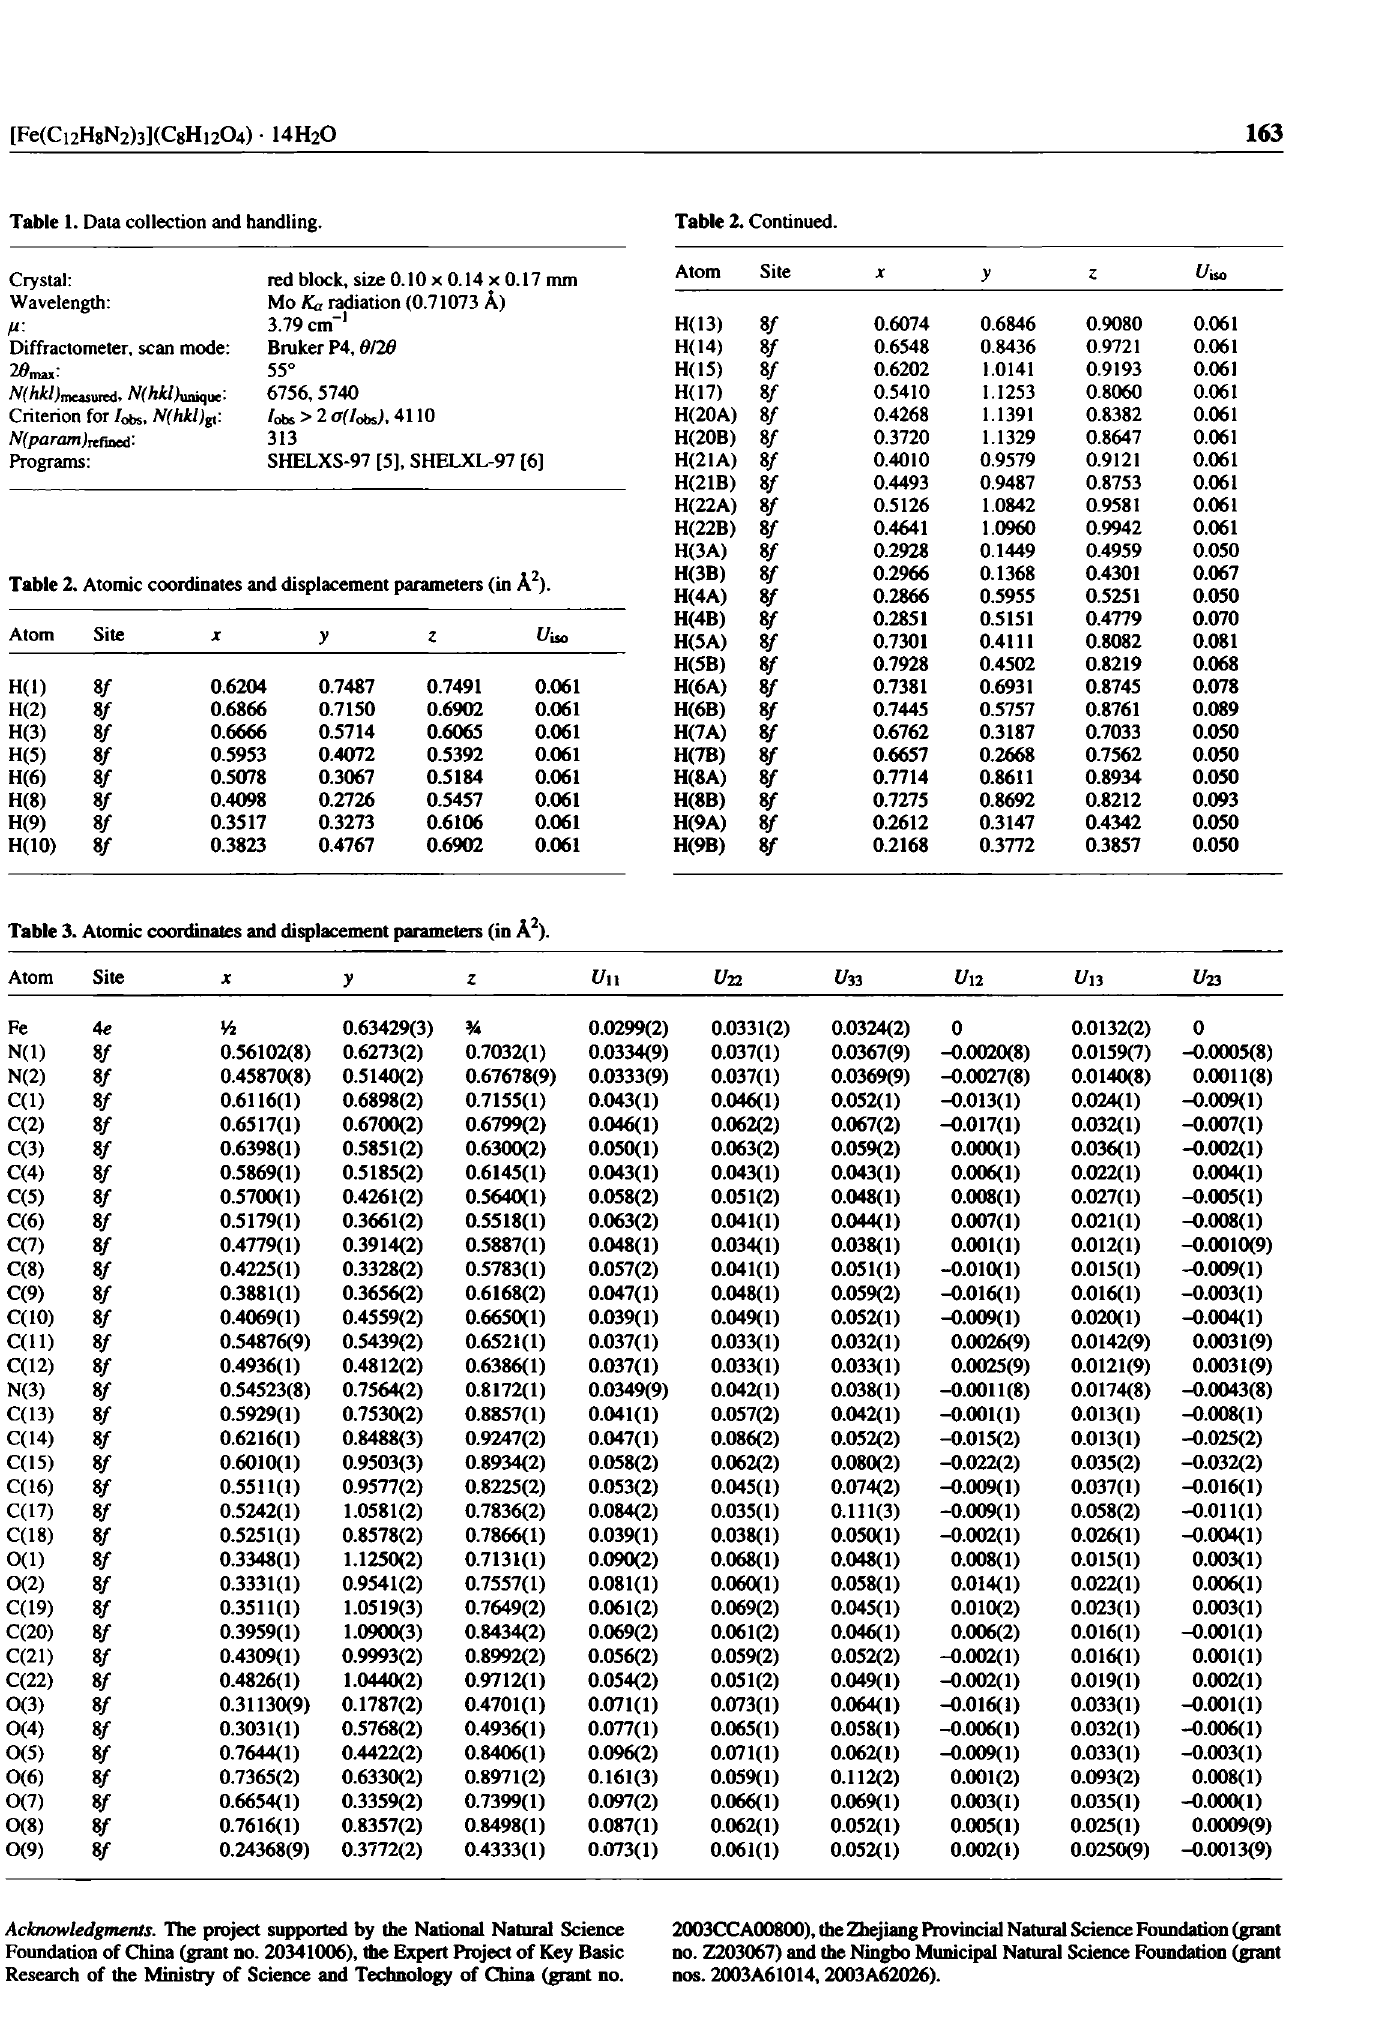
Table 2. Atomic coordinates and displacement parameters (in A 2 ).